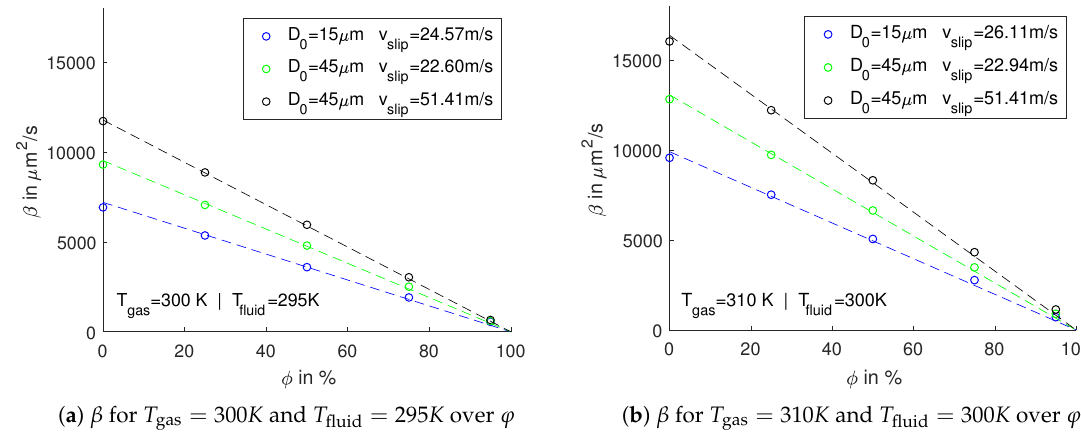
Figure 10. Evaporation rate β over relative humidity ϕ